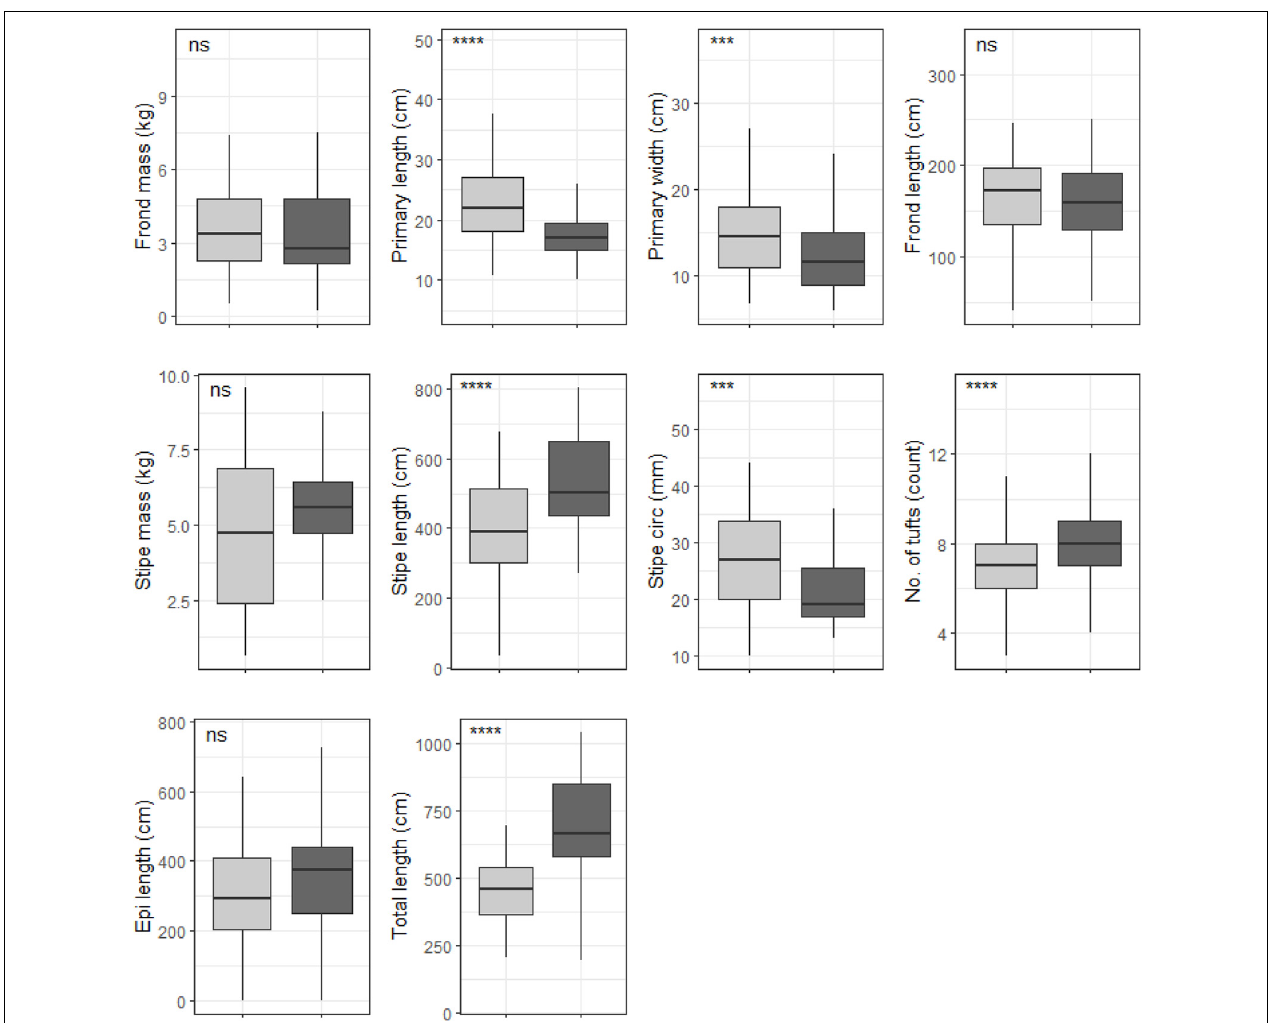
FIGURE 8 | Boxplots representing deep population E. maxima morphological characteristics grouped by temperature regime measured around the Western Cape coastline, with the y -axis depicting the specific morphology measured, with units provided. The lower and upper hinges correspond to the first and third quartiles. The whiskers represent the range, solid black lines represent the median and black dots are outliers. Light gray boxes represent cool-temperate and dark gray warm-temperate. Significance levels are as follows: * represents ≤ 0.05, ** represents ≤ 0.01, *** represents ≤ 0.001, **** represents ≤